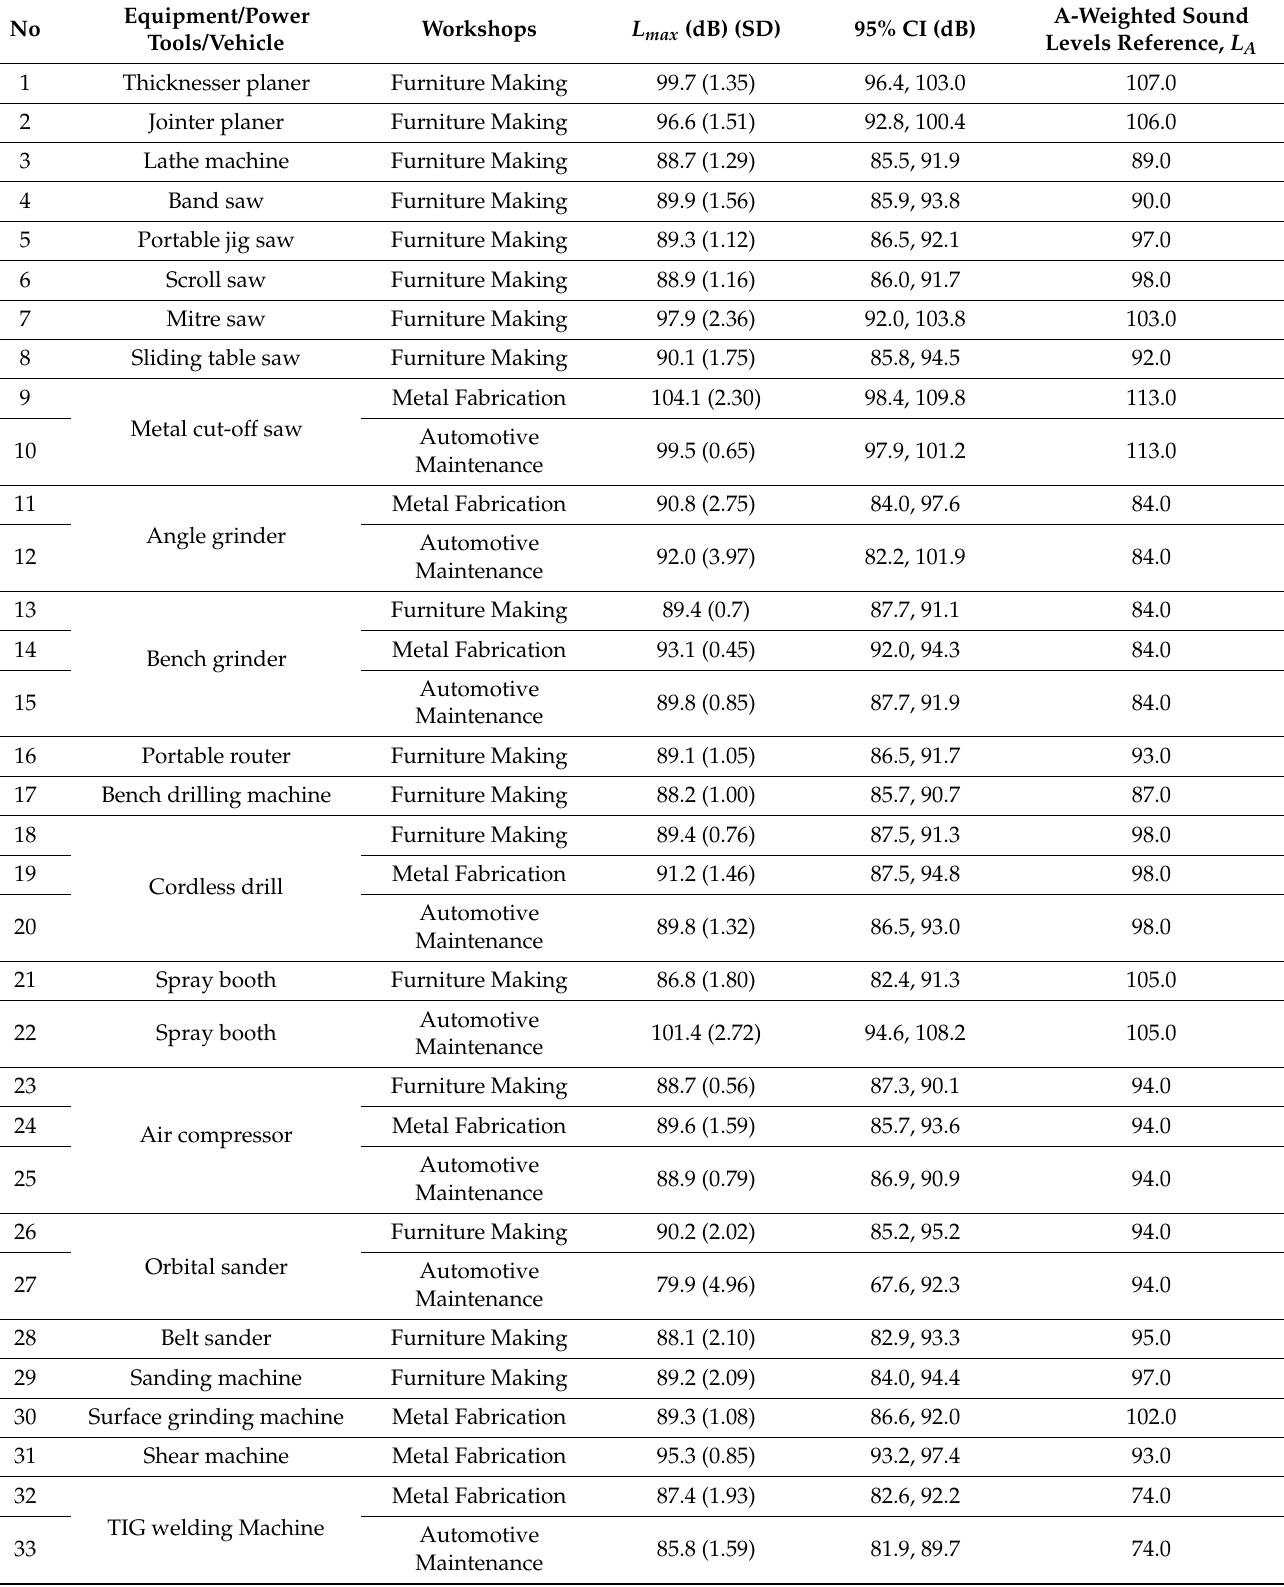
Table 5. Equipment, power tools and vehicle A-weighted maximum sound pressure level, L max